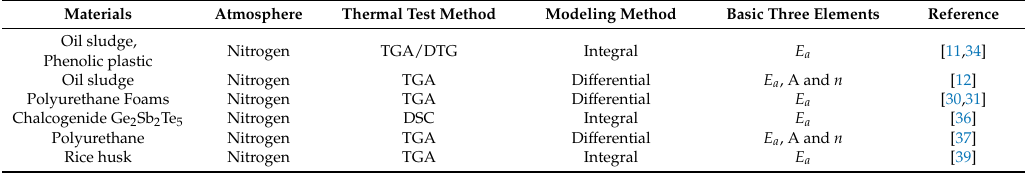
Table 1. Thermal kinetics analysis and modeling methods reported in the previous studies.